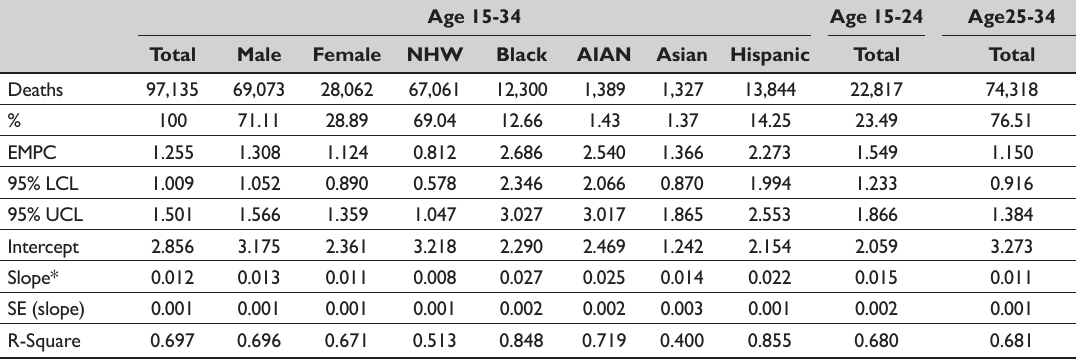
Table 1: Estimated Monthly Percent Changes (EMPC) in drug overdose mortality rates per one million population for US youth aged 15-34 from January 2018 through October